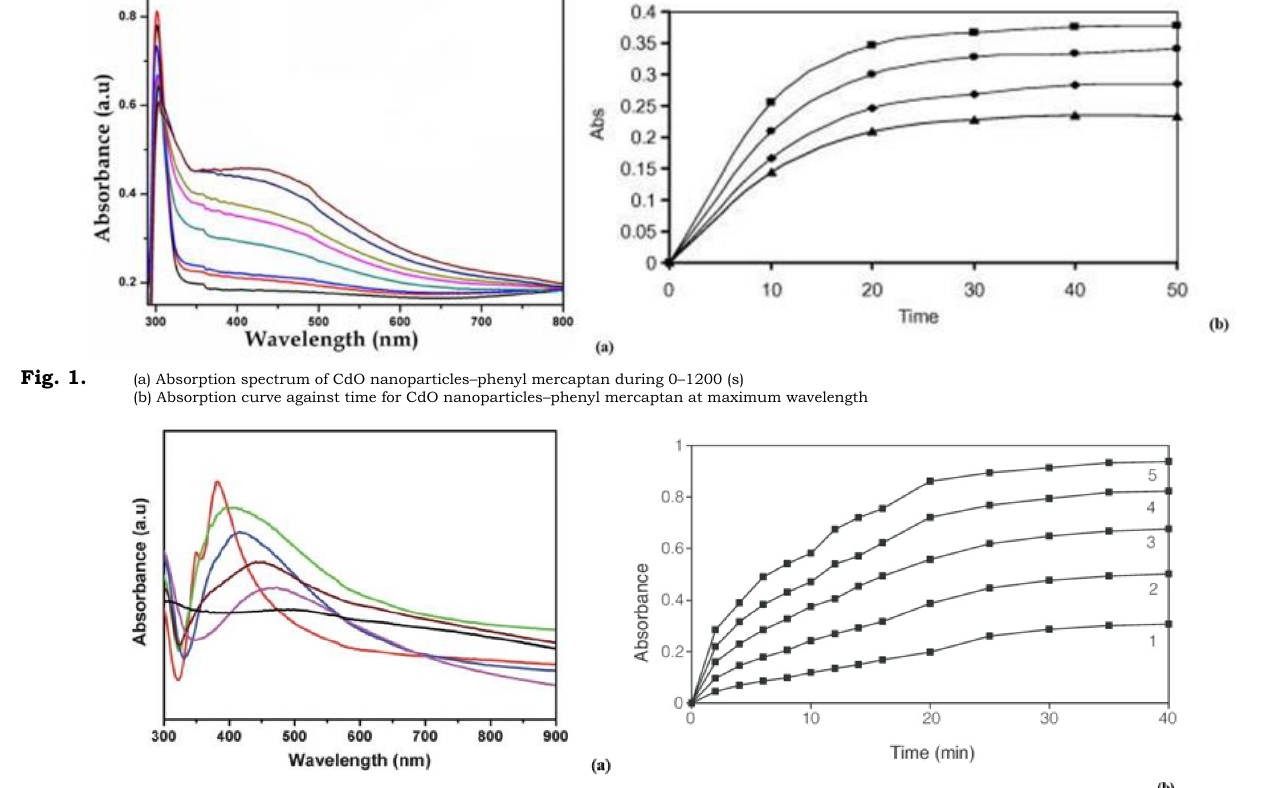
Fig. 2. (a) Absorption spectrum of CdO nanoparticles–benzyl mercaptan during 0–1200